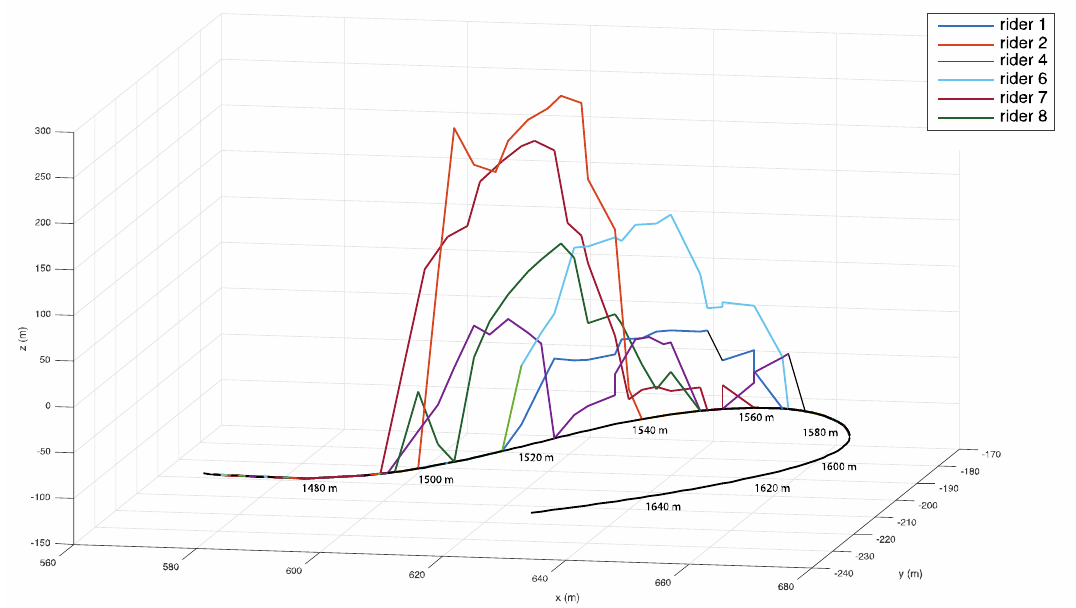
Figure 5. The normalized brake force applied by the rider in segment 6 during his fastest trial superimposed on the centerline of the descent. Riders 1, 6 and 8 have the fastest split times for this segment. Riders 2, 3 and 7 had the slowest split times. Note that the brake data of rider 5 and rider 3 is not